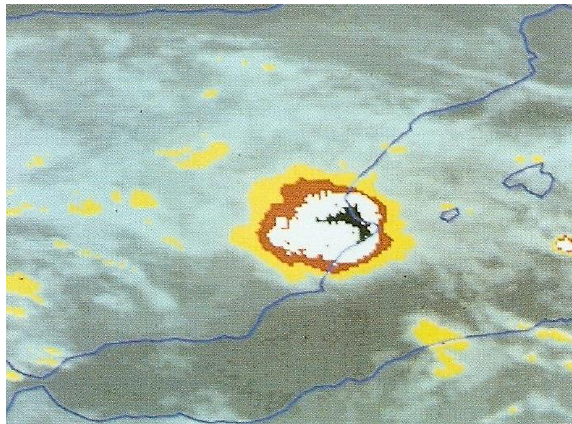
Figure 10.- Meteosat IR image on 05.30 UTC 4 November 1987. Red, white and black pixels indicate temperatures Fig. 10. Meteosat IR image on 05:30UTC, 4 November 1987. Red, below -42, -54 and -64 o C, respectively. white and black pixels indicate temperatures below − 42, − 54 and − 64 ◦ C,